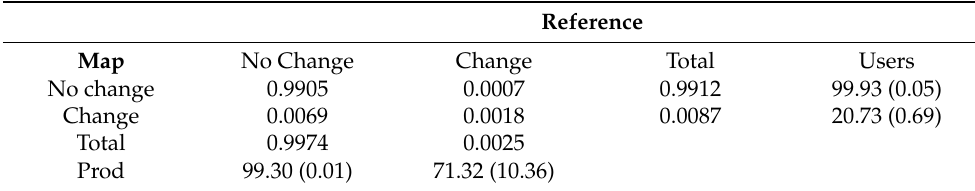
Table 10. Error matrix for the binary change and no-change classification for 2000 – 2005. The values in parentheses are standard deviations. OA = 99.23 ± 0.11%.